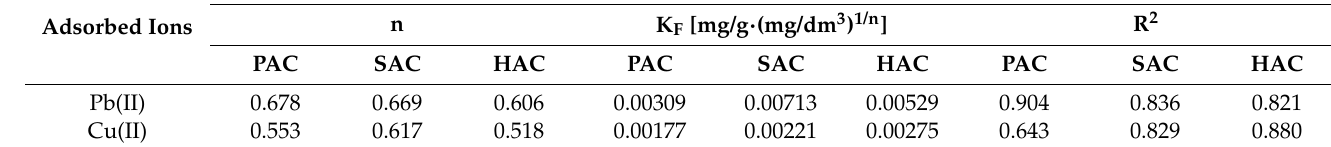
Table 7. The main Cu 2p photopeaks of PAC, SAC and HAC activated biocarbons.